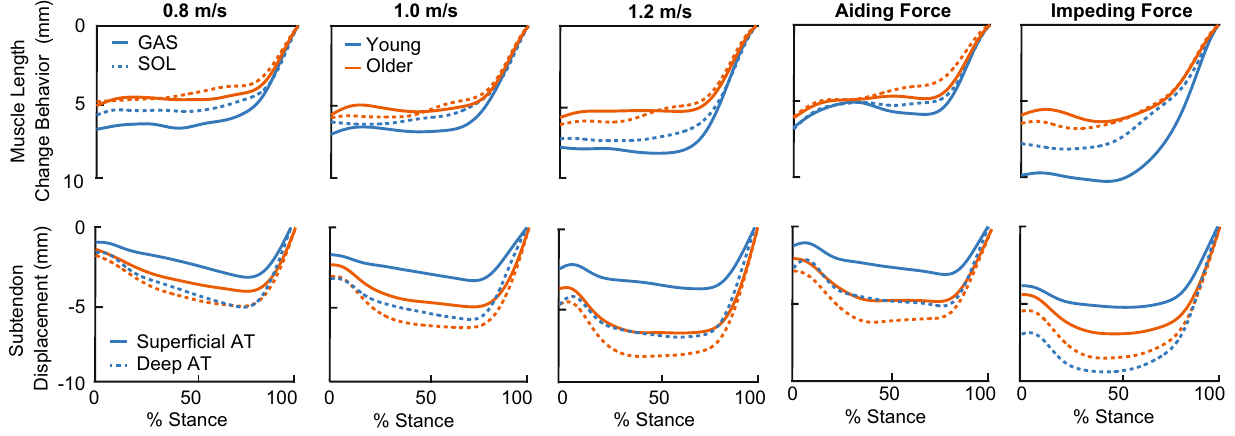
Figure 1. Time normalized, group average profiles for medial gastrocnemius (GAS) and soleus (SOL) longitudinal muscle length change (above) and superficial and deep Achilles tendon displacement (below) relative to toe-off for young (blue) and older (orange) adults.